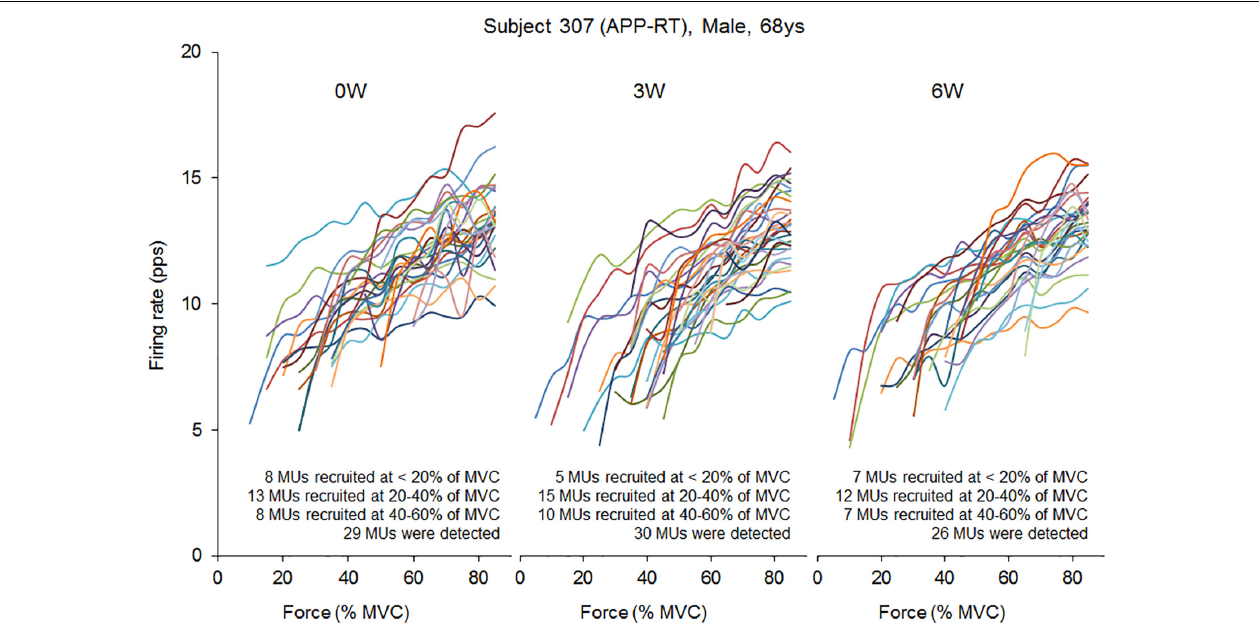
FIGURE 1 | Firing rate of individual motor units in a representative subject from APP-RT during ramp contraction at 0, 3, and 6 weeks.